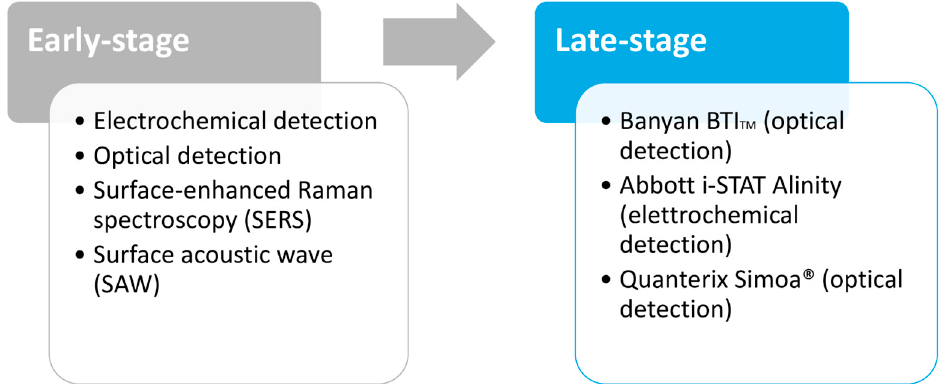
Figure 3. Current stage of development of detection devices for fl uid biomarkers.